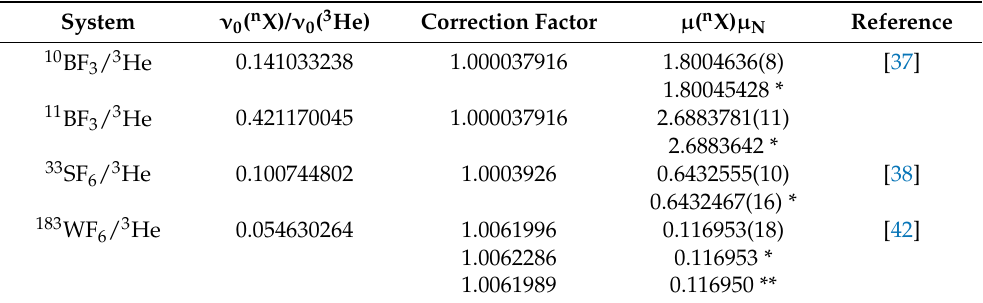
Table 4. NMR parameters for calculations for the nuclear magnetic moments of 10/11 B, 33 S, and 183 W against that of 3 He. System ν 0 ( n X)/ ν 0 ( 3